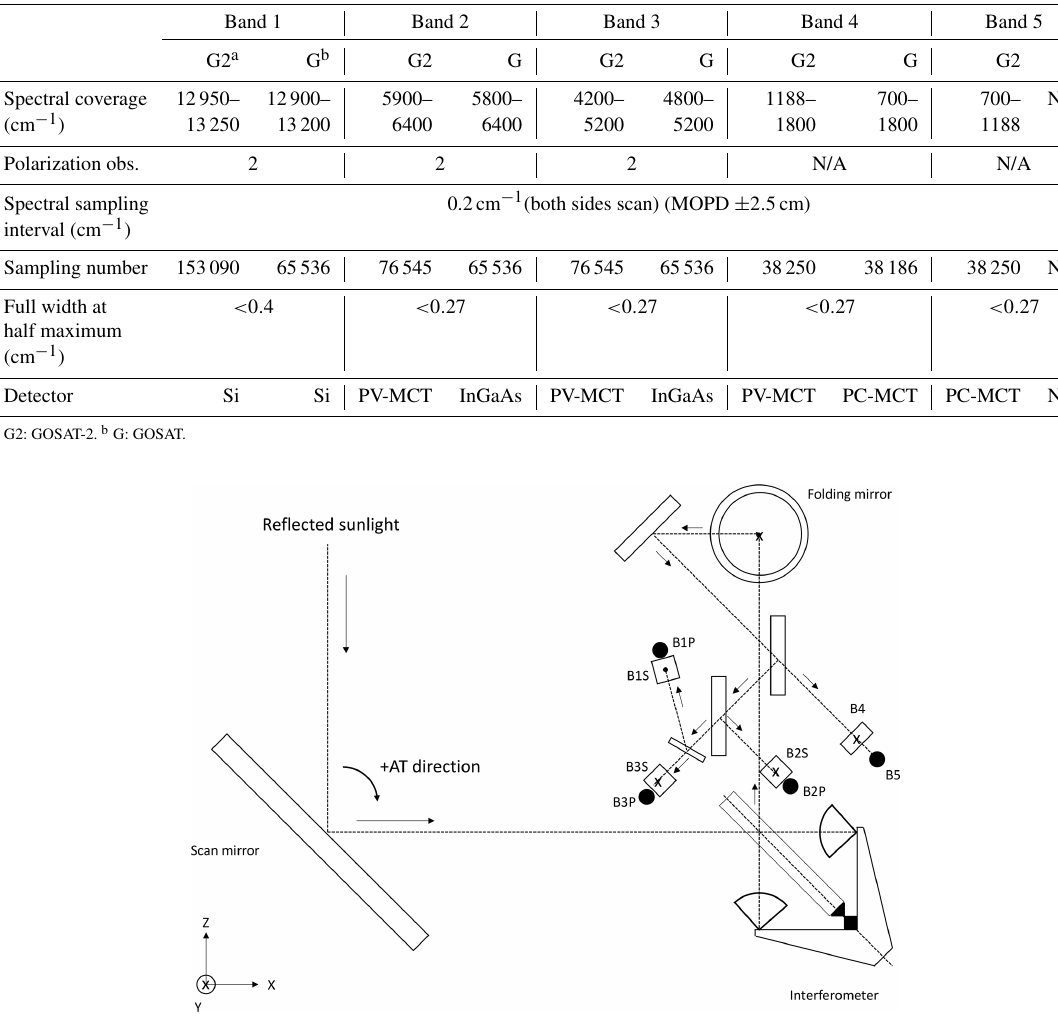
pulses are counted for each laser fringe interval as reference times for the optical path